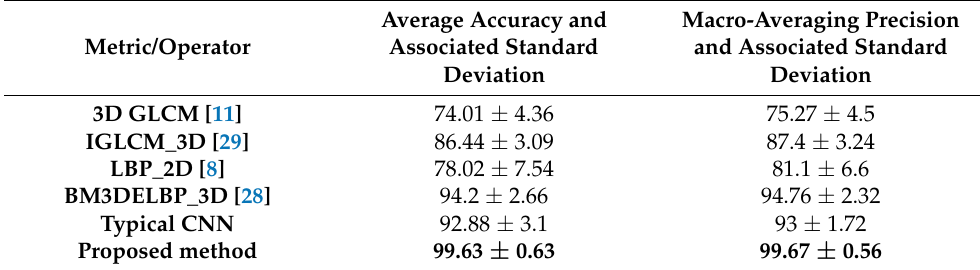
Table 4. Classification results for the first experiment with the SVM classifier [%].